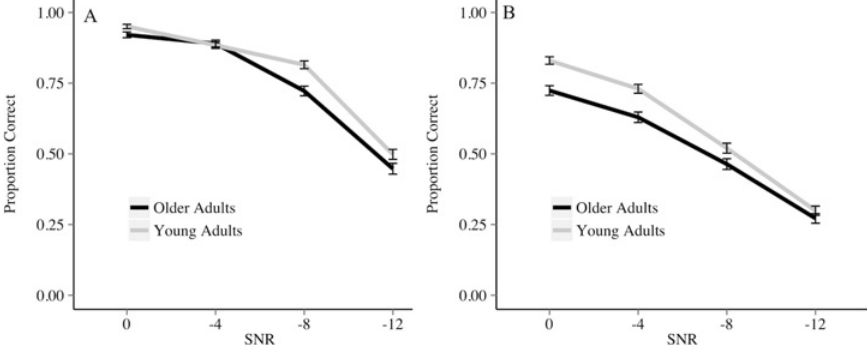
Fig 3. Proportion of keywords correctly identified by older and younger adults in the audio-visual meaningful (A) and anomalous (B) semantic contexts. Bars represent standard error.